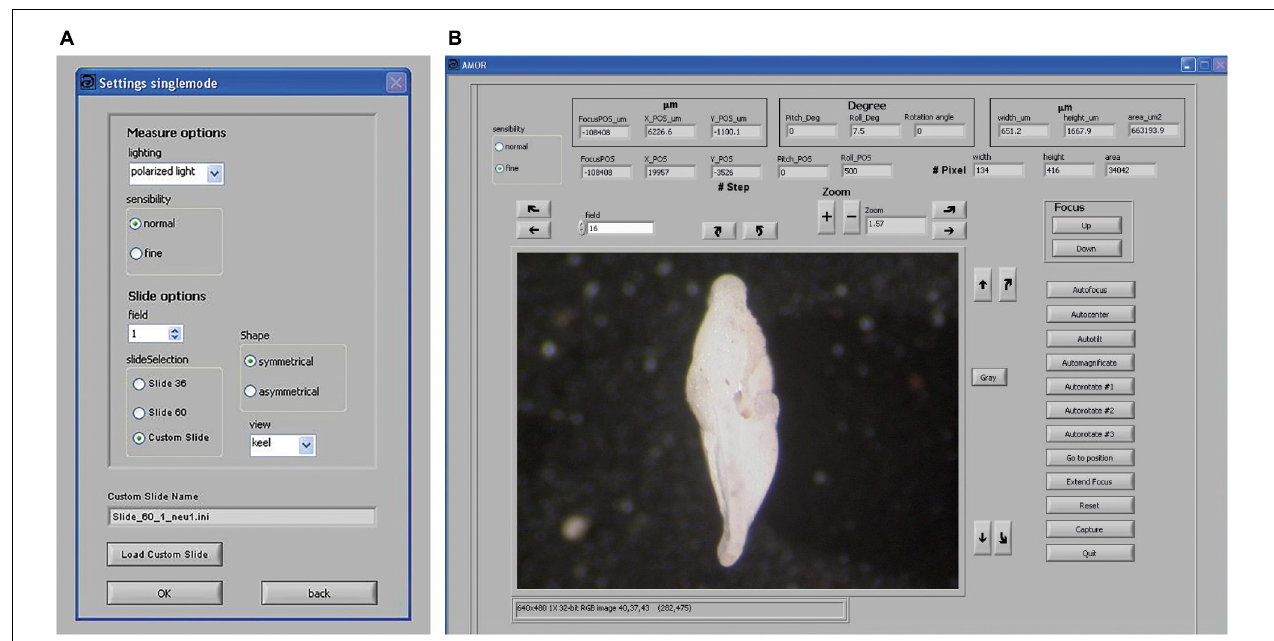
FIGURE 6 | Graphical user interface (GUI) in System AMOR 2. (A) Settings for the manual mode. (B) GUI for working in manual mode. Right above the video image, there are buttons for horizontal translation of the stage in the X direction (straight arrows), tilting left/right (Roll) (curved arrows), zooming in and out (“ + ” and “–” buttons), and soft rotation of the specimen (a pair of curved arrows on the left side of the zoom button). Next to the video image on the right-hand side, there are buttons for translation of the stage in the Y -direction (straight arrows), tilting forward/backward (Pitch), and for toggling between a color image and a black/white image (“Gray”). On the outer right side of the AMOR panel, buttons are for focusing up and down, and more complex functions like Autofocus, AutoCenter, AutoTilt, Automagnificate, three options for AutoRotate, Go to Position, Extend Focus, Reset, and commands for image capturing and Quit. The top row of the AMOR panel (three boxes from left to right): The left box returns the focus position and X and Y coordinates of the centroid of the particle, all in µ m or motor steps. The middle box returns inclinations (Pitch, Roll) of the stage and the soft rotation angle of the particle. The right box returns spiral height (width), axial length, and the area of the particle. Note that the illustrated specimen is shown in the “North–South” orientation (see